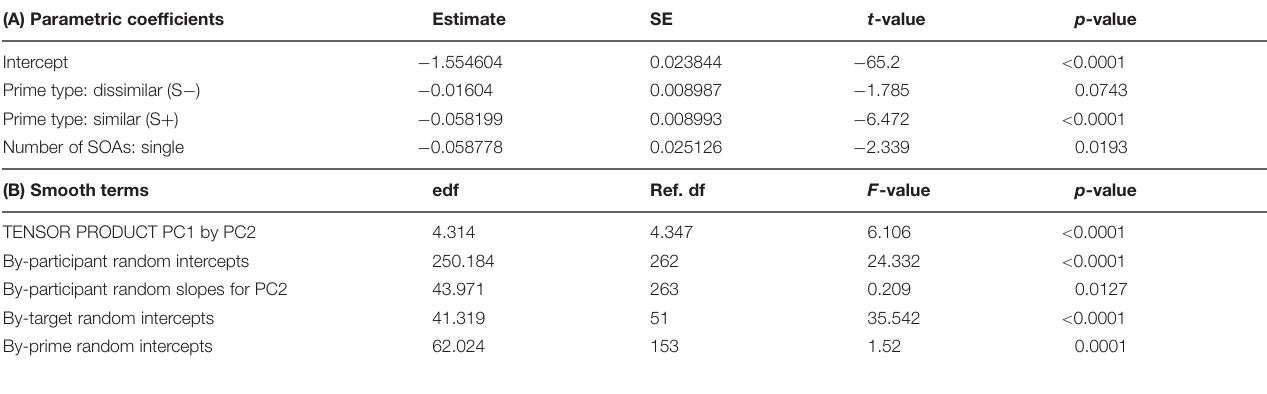
TABLE 5 | Generalized additive mixed model fitted to the lexical decision latencies for 48 ms SOA, reporting parametric coefficients (A), and non-linear terms, tensor products, and random effects (B) with effective degrees of freedom (edf), reference degrees of freedom (Ref. df), F , and p